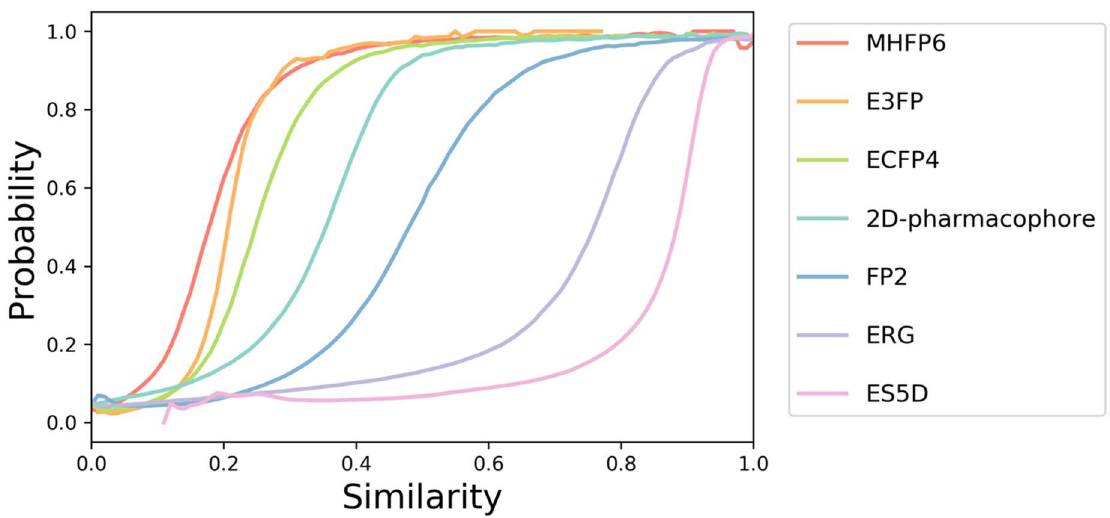
Figure 1. Probability curves. Probabilities to have a common protein target for a pair of compounds with a given similarity calculated with seven different methods (MHFP6, E3FP, ECFP4, 2D-pharmacophore, FP2, ERG, and ES5D). The probability curves were generated using a dataset containing 10 million pairs of compounds sharing the same protein target as confirmed experimentally with binding or functional assays, and 100 million pairs of randomly selected compounds.